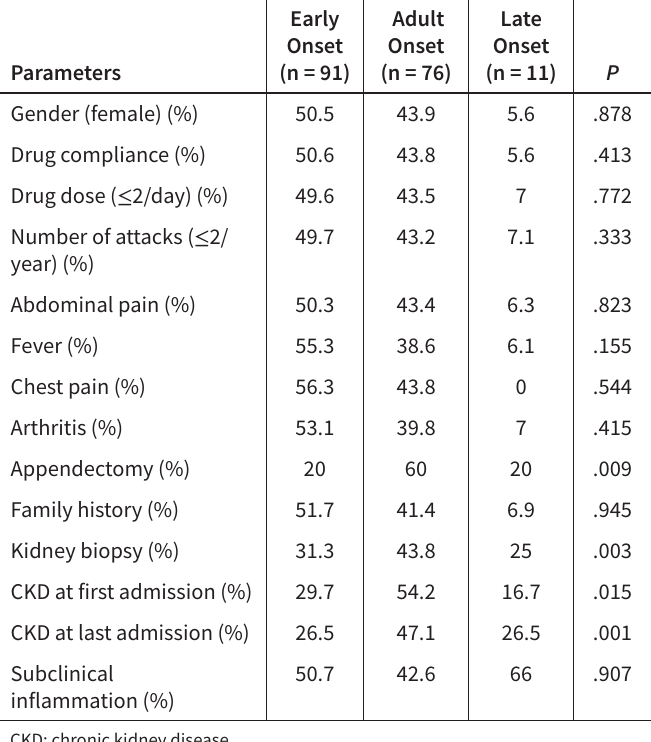
Table 2. Comparison of the 3 Groups in Terms of Clinical Features